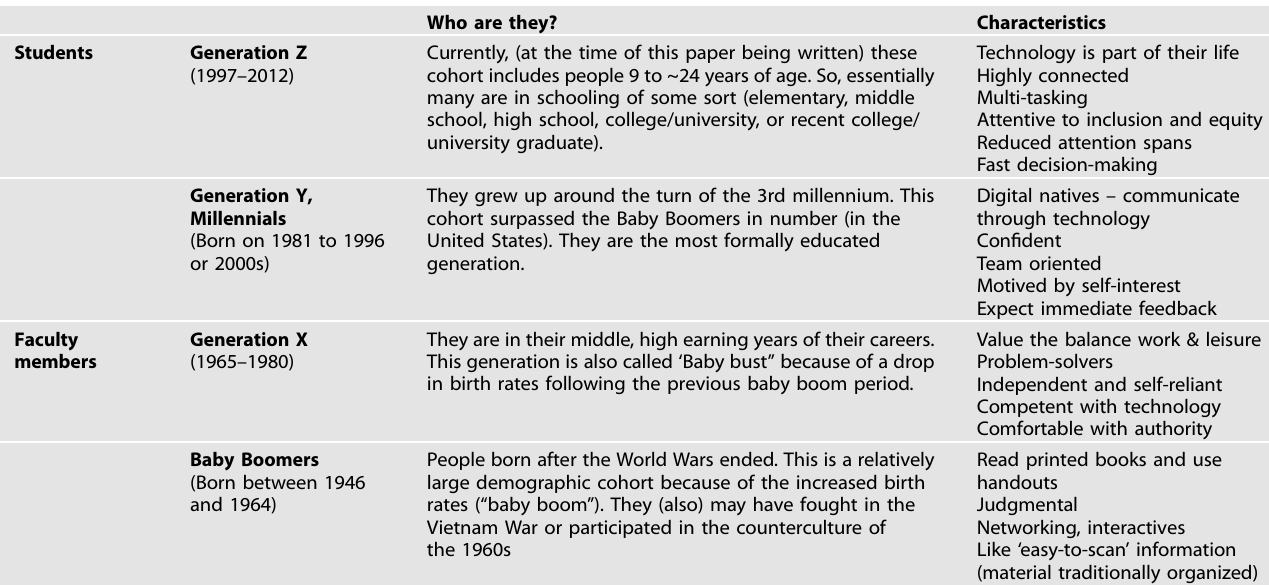
Table 1. Timeline showing different cohorts of generations that participated in this study.